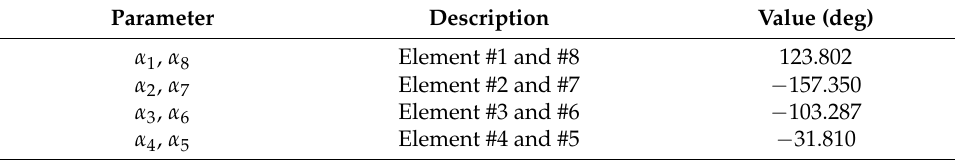
Table 2. Radiating Element Rotation Angles — Design 1.